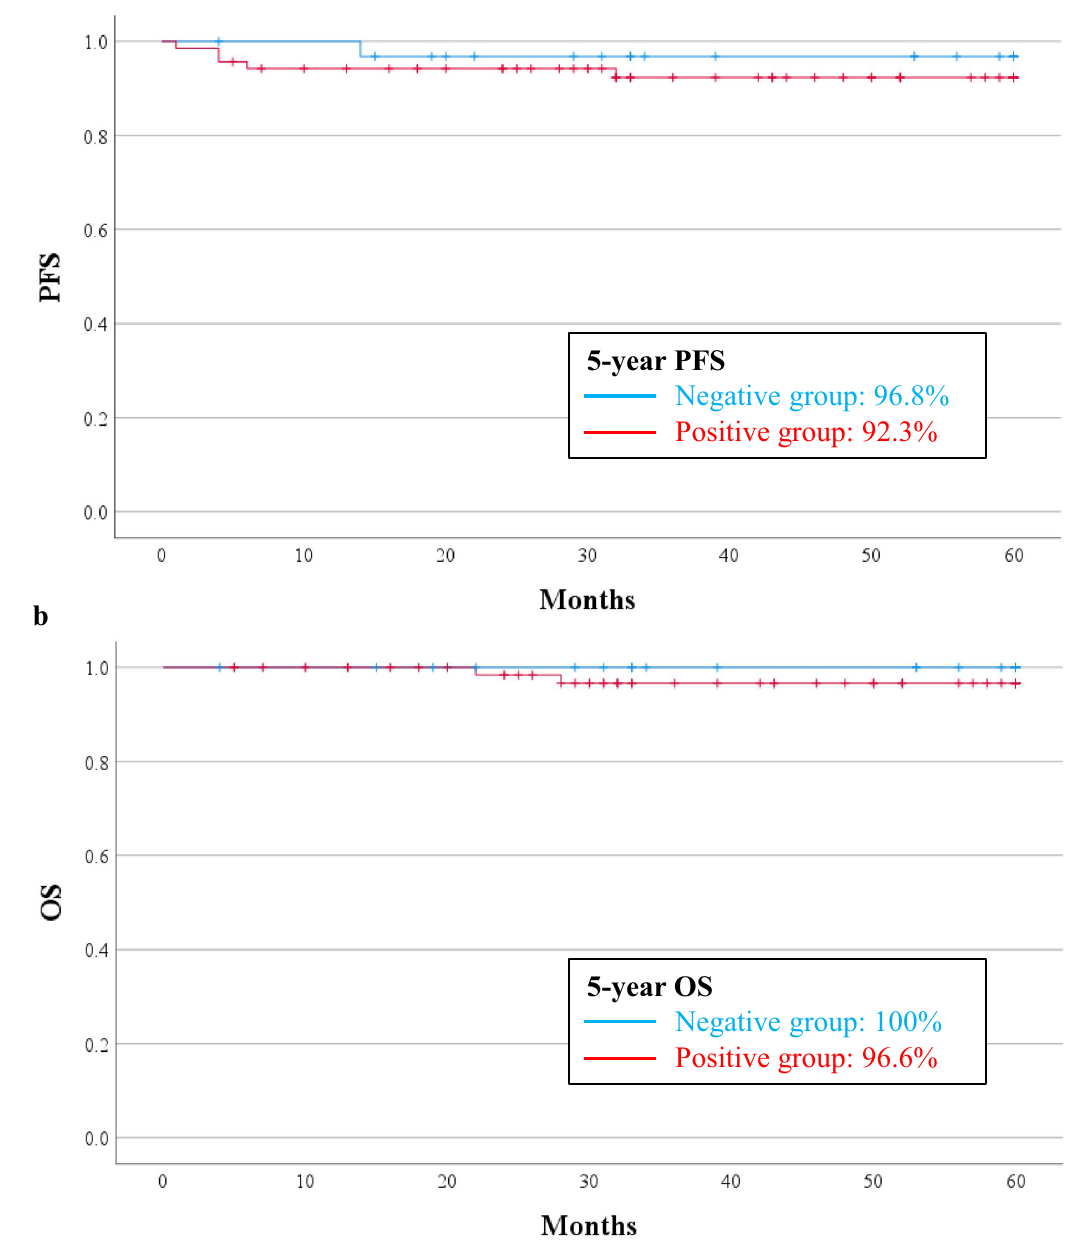
Figure 3. Prognosis of the patients. Kaplan–Meier curves showing (a) PFS and (b) OS stratified by the positive and negative margin groups. Survival curves were compared using the log-rank test, but there were no significant differences in PFS and OS between the two